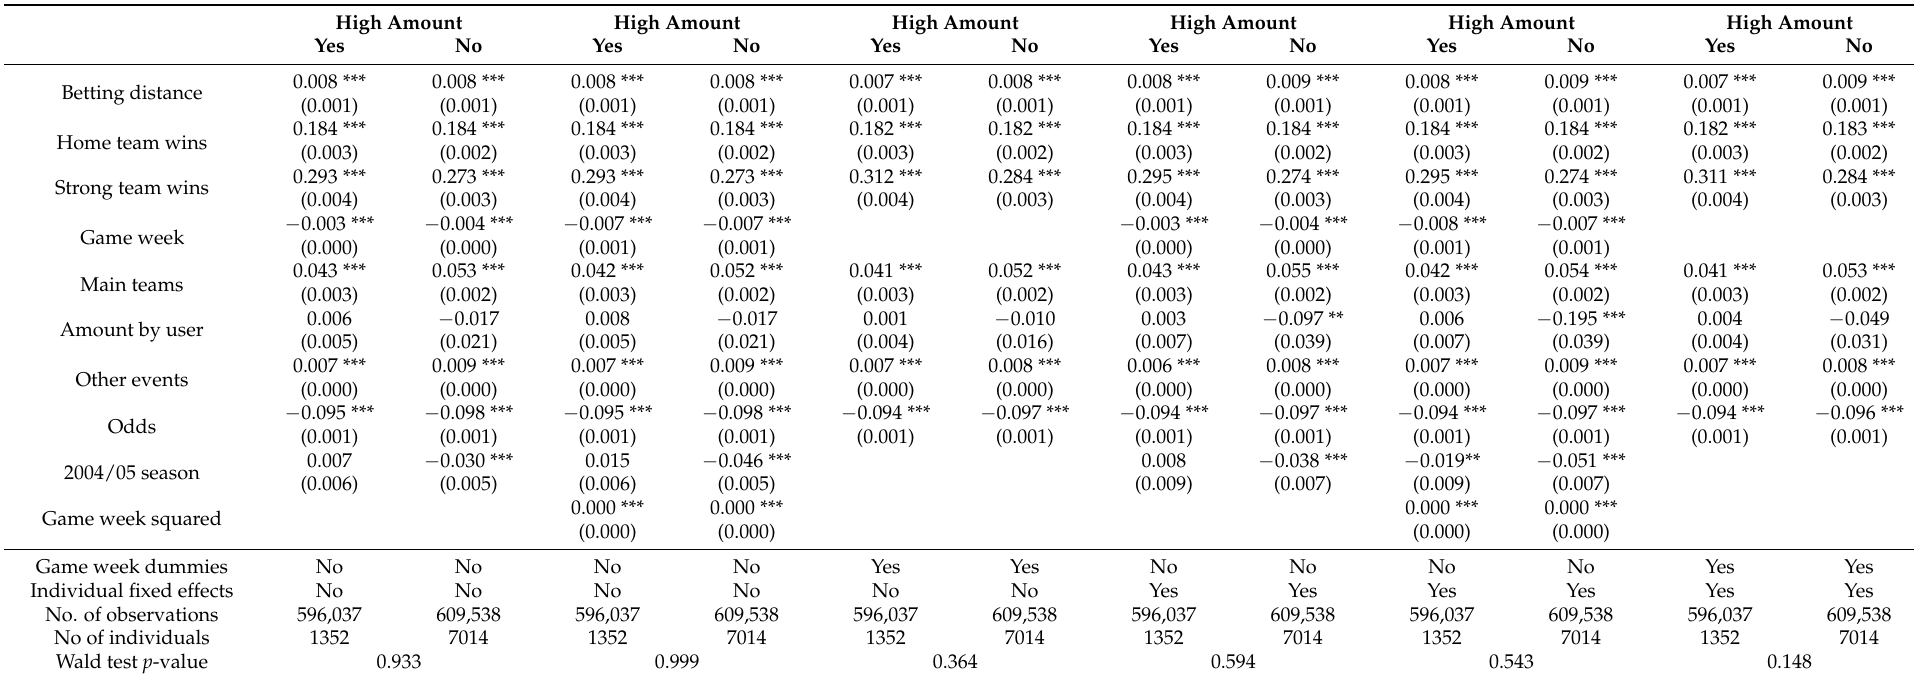
Table 3. Heterogeneity: bets involving larger-than-median-amount vs.